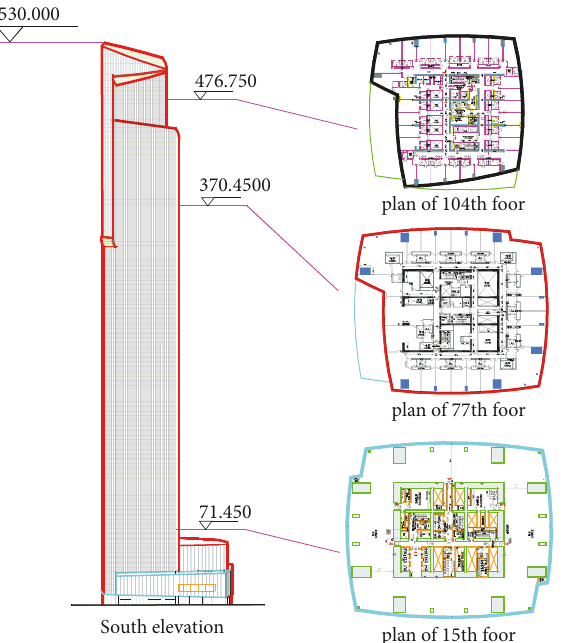
Figure 4: Elevation and typical plane of Guangzhou East